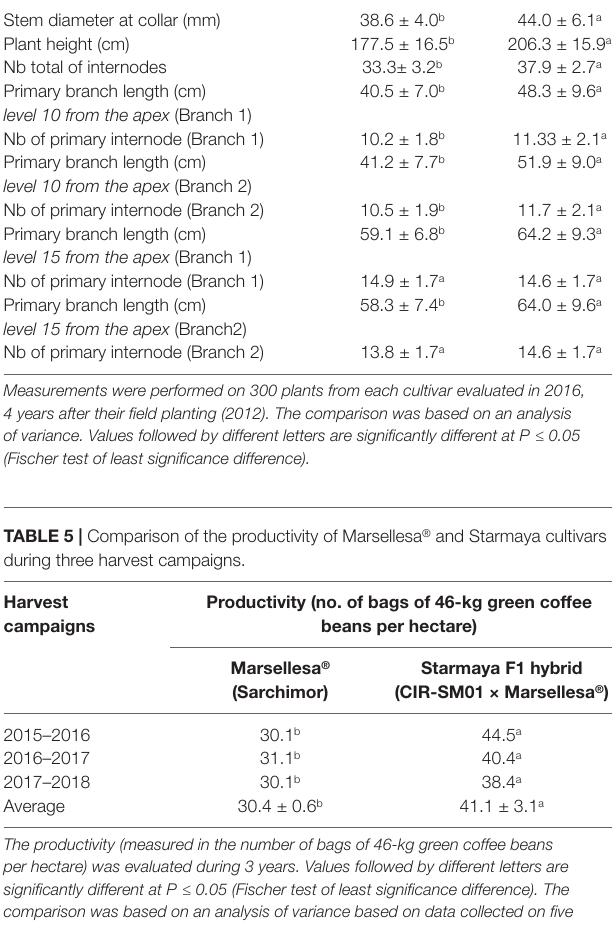
TABLE 4 | Phenotypic comparison of C. arabica Marsellesa ® Sarchimor cultivar and Starmaya F1 hybrid (CIR-SM01 × Marsellesa ® ). Parameters